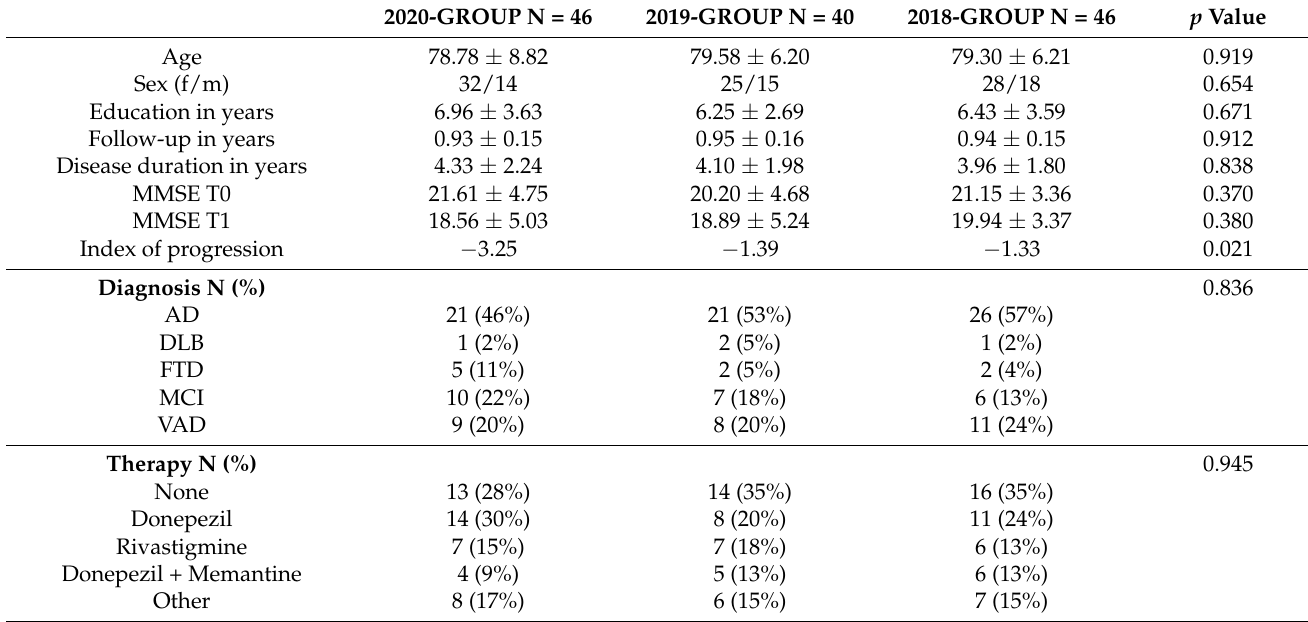
Table 1. Subject demographic, clinical, and cognitive characteristics.